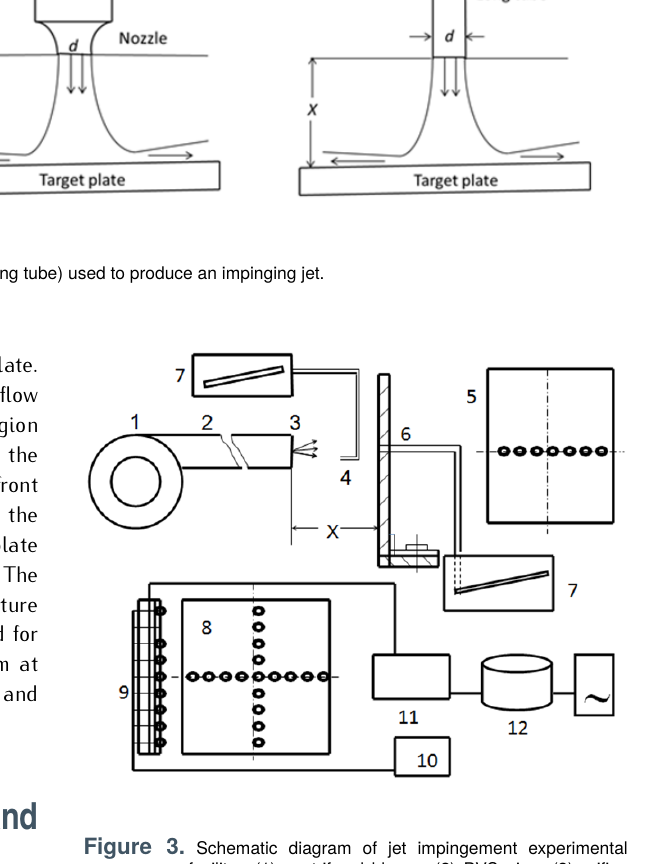
Figure 3. Schematic diagram of jet impingement experimental facility. (1) centrifugal blower, (2) PVC pipe, (3) orifice plate, (4) Pitot tube, (5) pressure target plate, (6) static pressure hole, (7) manometer, (8) heat transfer target plate, (9) thermocouples, (10) recorder, (11) digital multimeter, (12) DC power